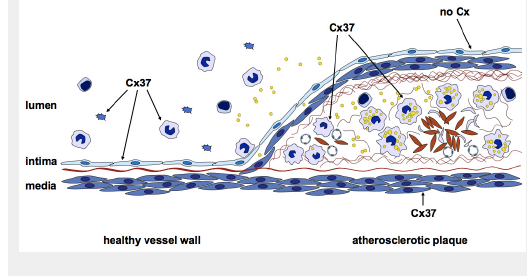
Connexins are differentially expressed during atherosclerotic plaque development. In the healthy vessel wall (left), Cx37 is expressed by ECs and monocytes. In contrast, at the site of an atherosclerotic plaque (right), Cx37 is expressed by SMCs and macrophages and is no longer expressed by the endothelium overlaying the